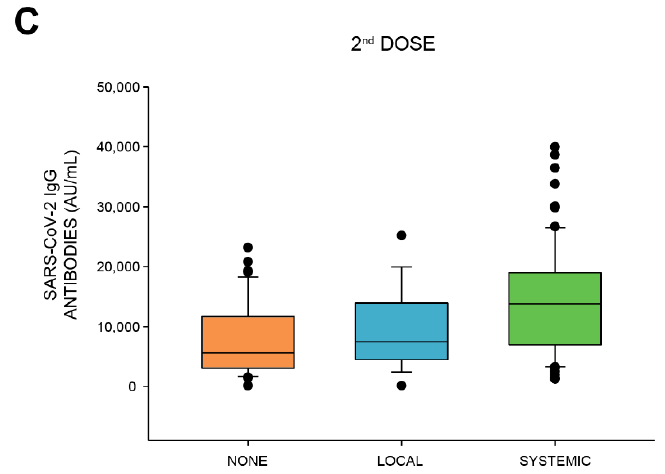
Figure 3. Association between SARS ‐ CoV ‐ 2 IgG antibody response and adverse reactions. SARS ‐ CoV ‐ 2 IgG levels in vaccinees who experienced no adverse reactions, isolated local adverse reactions, or any systemic adverse reaction ( A ) following either dose (Kruskal–Wallis One Way Analysis of Variance on Ranks: p < 0.001), ( B ) the first dose (Kruskal–Wallis One Way Analysis of Variance on Ranks: p < 0.05) or ( C ) the second dose (Kruskal–Wallis One Way Analysis of Variance on Ranks: p < 0.001). A positive response is defined as ≥ 50 AU/mL.